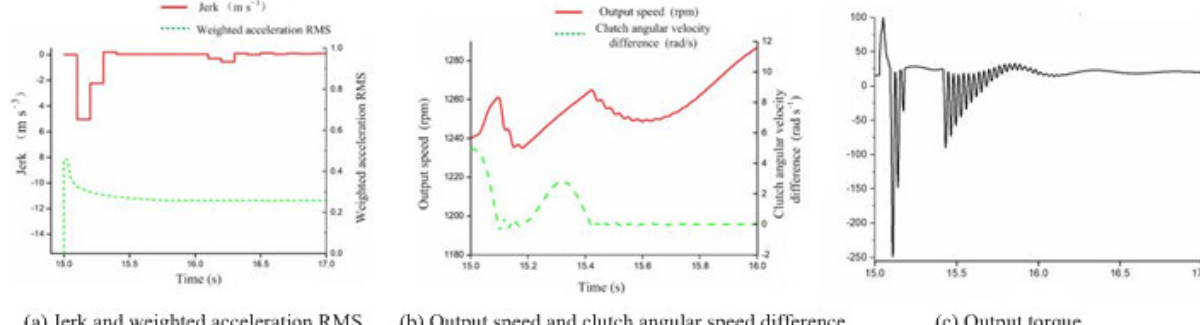
Figure 14. Test results after factor level